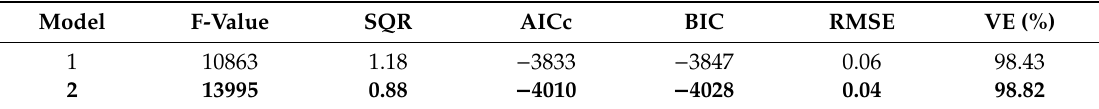
Table 3. Goodness-of-fit and over-parameterization statistical parameters of the tested kinetic models for the enzymatic esterification of ibuprofen and glycerol. SQR: sum of quadratic residues; AICc: Akaike information criterion; BIC: Bayesian information criterion; RMSE: root mean square error. In bold, the statistical parameters corresponding to the selected kinetic